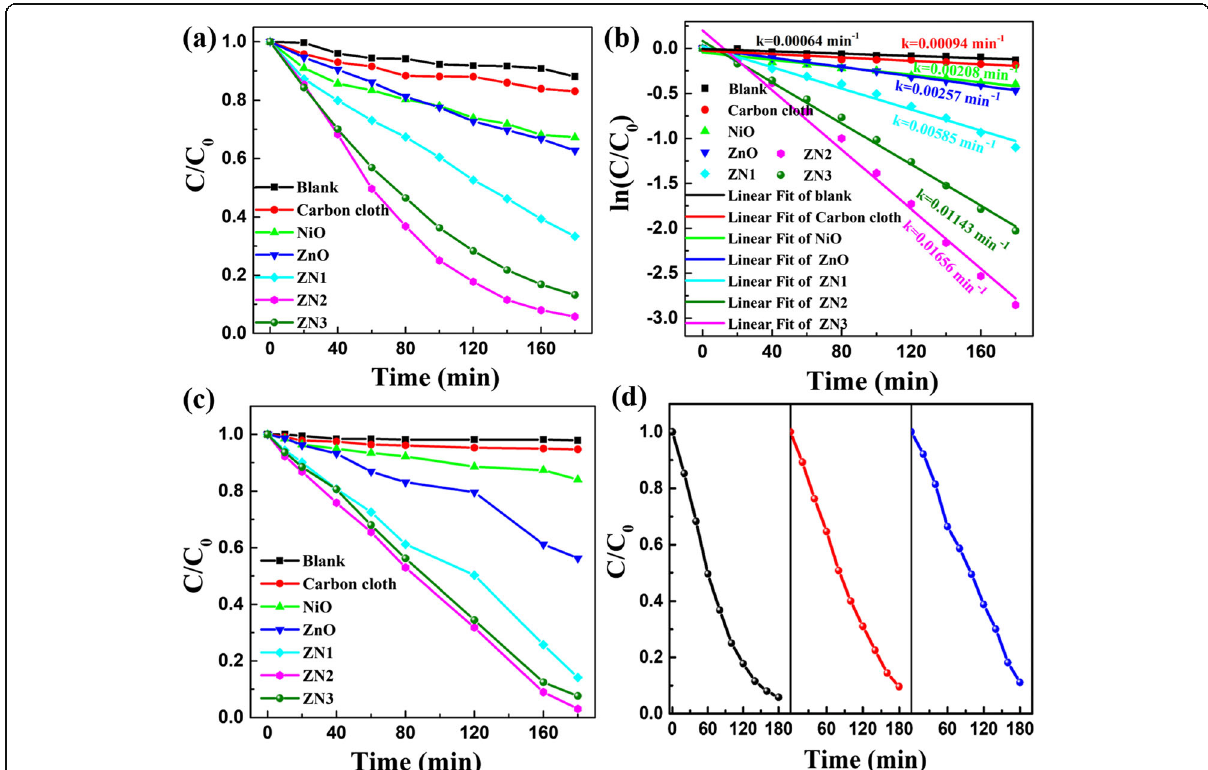
Fig. 7 a Plots of relative concentration (C/C 0 ) of RhB versus time for the degradation of RhB over ZN1, ZN2, ZN3, and ZnO nanorods and NiO nanosheets under UV light irradiation. b Corresponding plots of − ln( C t / C 0 ) versus irradiation time. c Plots of relative concentration ( C / C 0 ) of MO versus time for the degradation of MO over ZnO, NiO, and ZnO@NiO heterostructure under UV irradiation. d Repeated photocatalytic degradation of RhB over